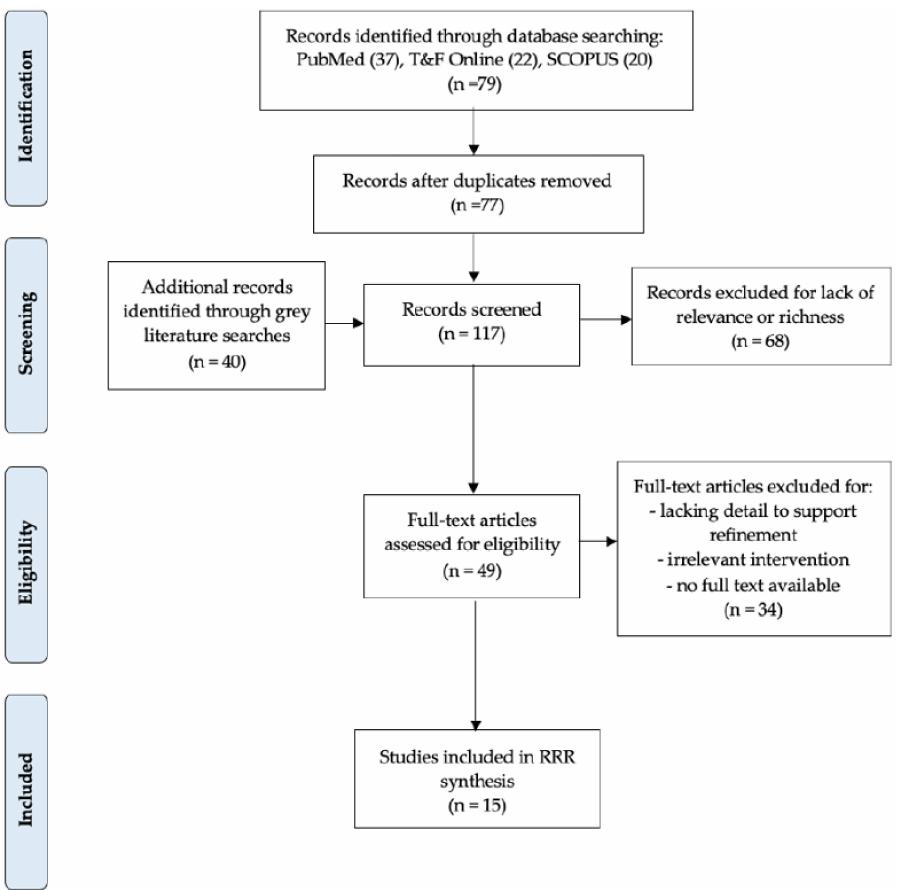
Figure 2. Modified PRISMA